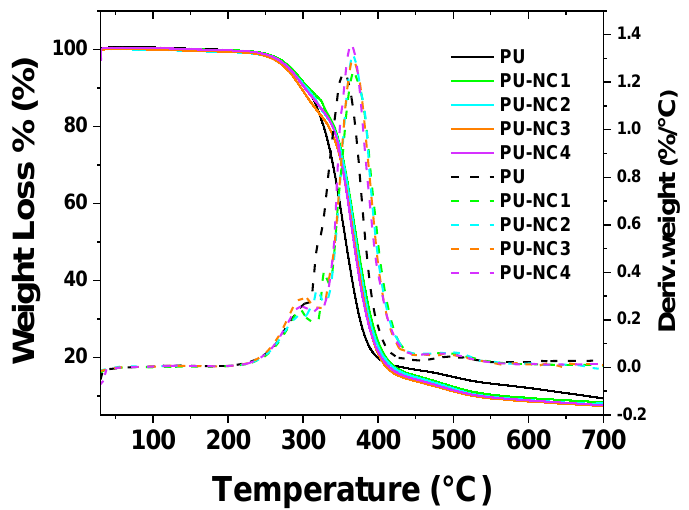
Figure 5. TGA and DTG analyses of the polyurea-polyurethane-MWCNTs nanocomposites. Table 2. Thermal properties of polyurea-polyurethane-MWCNTs nanocomposites. Sample T 10% , [°C] T max , [°C] PU